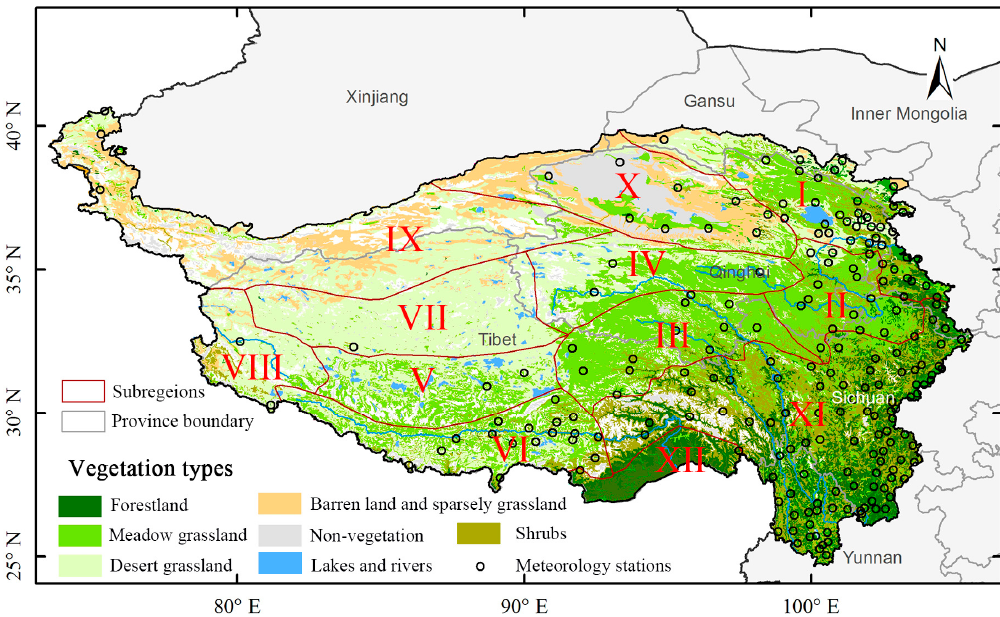
Figure 1. Study area and geographical subregions. The black circles represent the locations of 209 meteorological stations on the Qinghai-Tibetan Plateau.